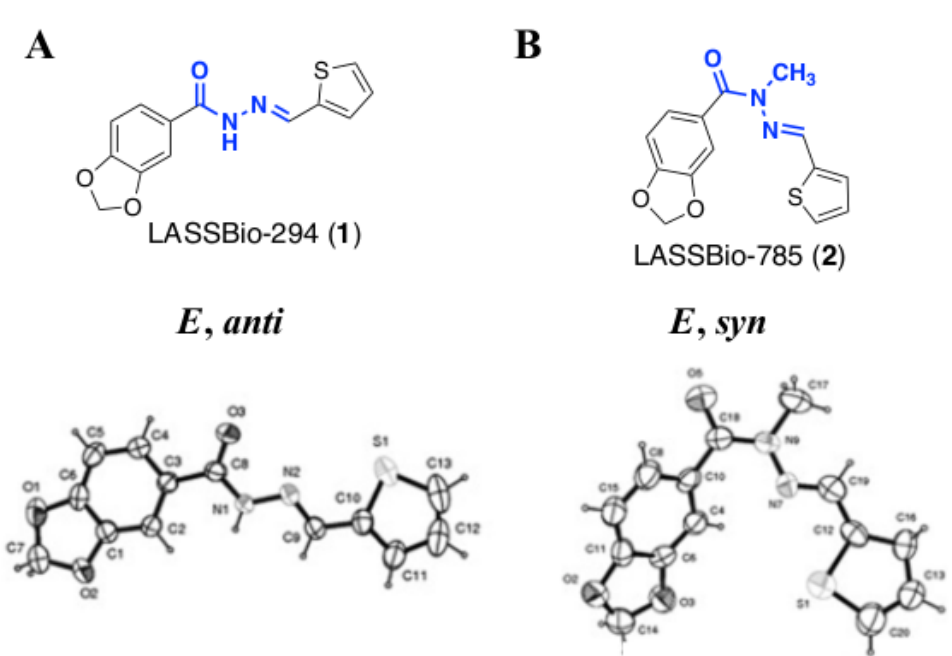
Figure 1. Conformational effect by N -methylation of the amide of NAH function, from anti- to syn- conformation of cardioactive compounds LASSBio-294 ( 1 ) and LASSBio-785 ( 2 ). ( A ) Chemical and X-ray structure of LASSBio-294 ( 1 ); ( B ) Chemical and X-ray structure of LASSBio-785 ( 2 ). The careful structure–property–activity relationship of LASSBio-294 ( 1 ) and LASSBio- 785 ( 2 ) demonstrated that the N -methylation of the NAH moiety has a profound effect on this scaffold [14], leading to different electronical profiles (identified by 1 H and 13 C NMR studies) and physicochemical properties [15,16]. Follow up studies by X-ray diffraction indicated that the two compounds adopted an unexpected distinct conformation [15], with 1 having a hair-pin like conformation (Figure 1A) and 2 a U-shape conformation (Figure 1B) [17]. In both conformations (Figure 1A,B), it is outstanding to note that the heteroatom of the ring at the imine double bond adopted the same steric orientation viz- à -viz the N sp 2 corresponding to a typical chalcogen interaction. This conformational behavior was investigated, confirming the steric orientation of the 2-thiophene ring at the terminus of LASSBio-294 ( 1 ) and LASSBio-785 ( 2 ), as an accountable σ -hole or chalcogen interaction [18–20] between S -atom and the electron-pair of the N- sp 2 atom of the NAH moiety [21]. This observation suggests that this kind of interaction could be helpful in drug design to address conformational restrictions in bioactive NAH derivatives [21] (Figure 2).